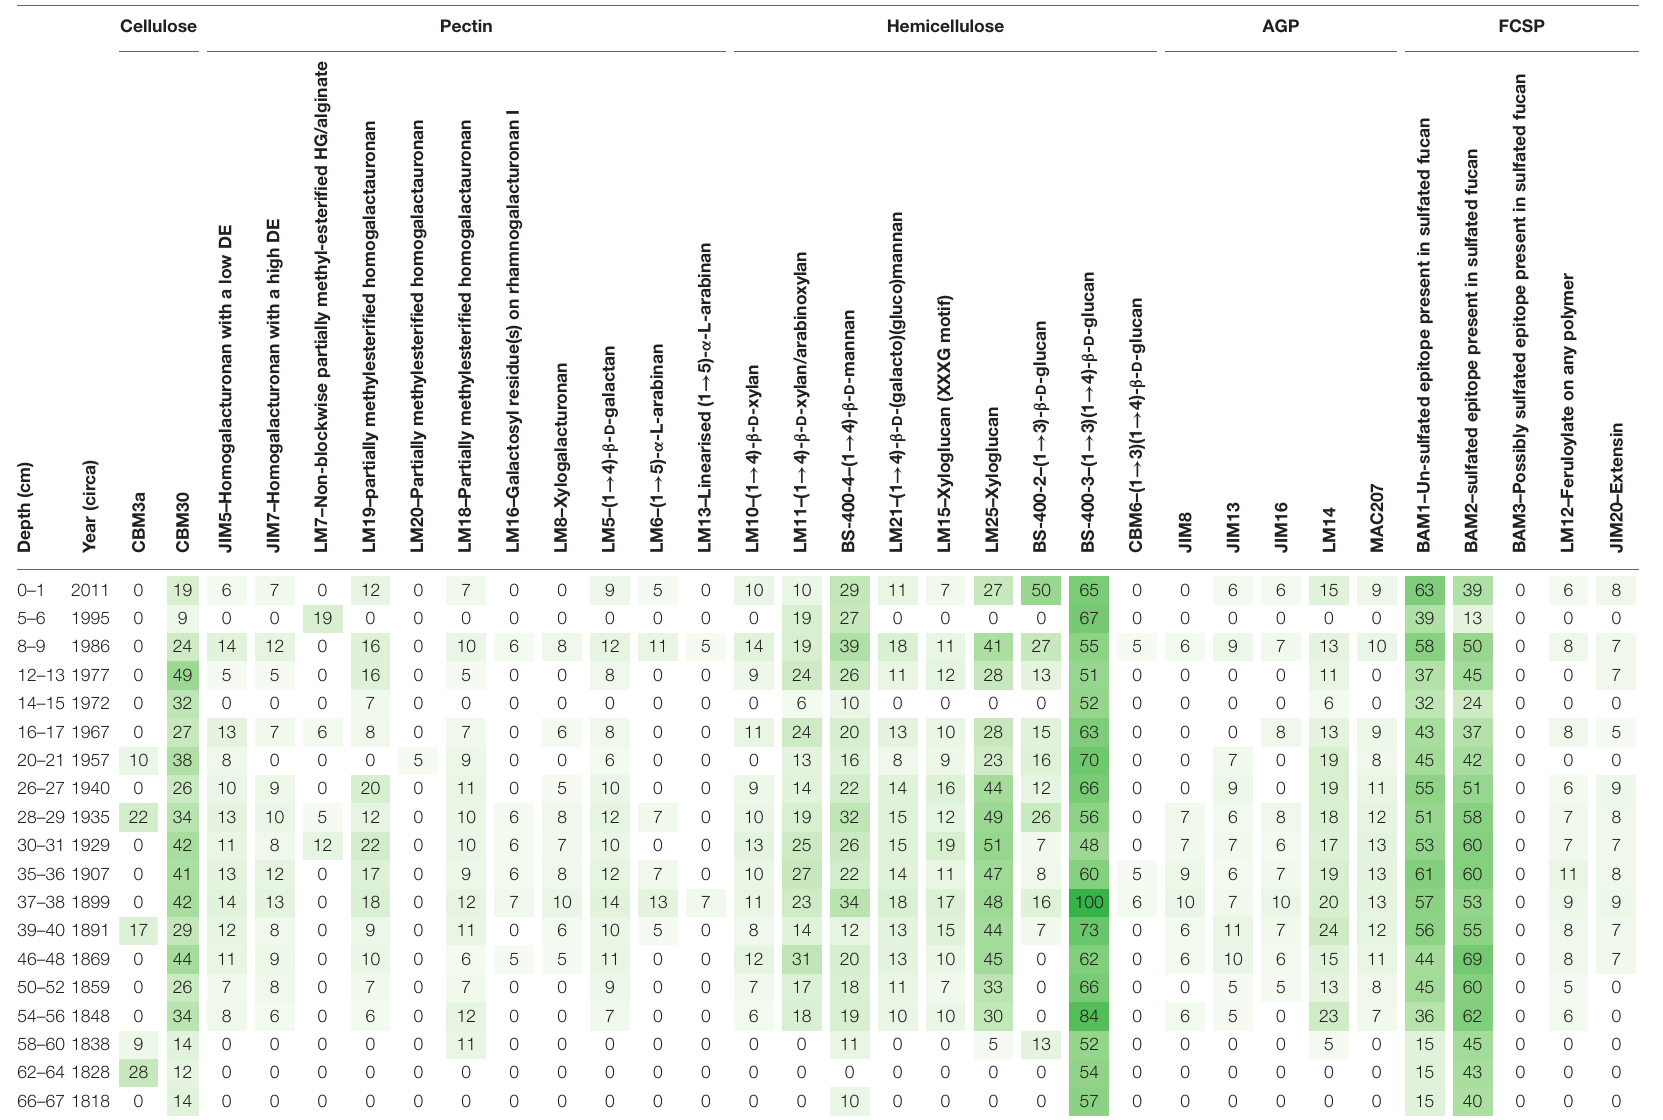
TABLE 4 | Heat map for NaOH extractions from the core samples from KF12/5. Cellulose Pectin Hemicellulose AGP